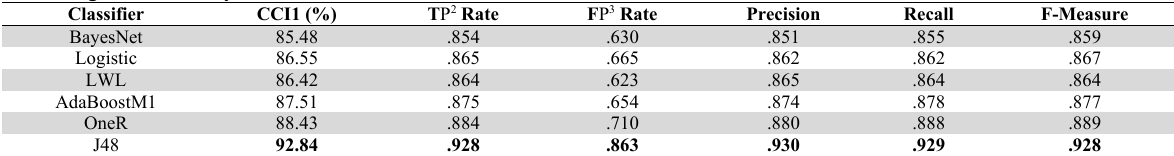
Predicting the META by PU, PV, PEOU, and